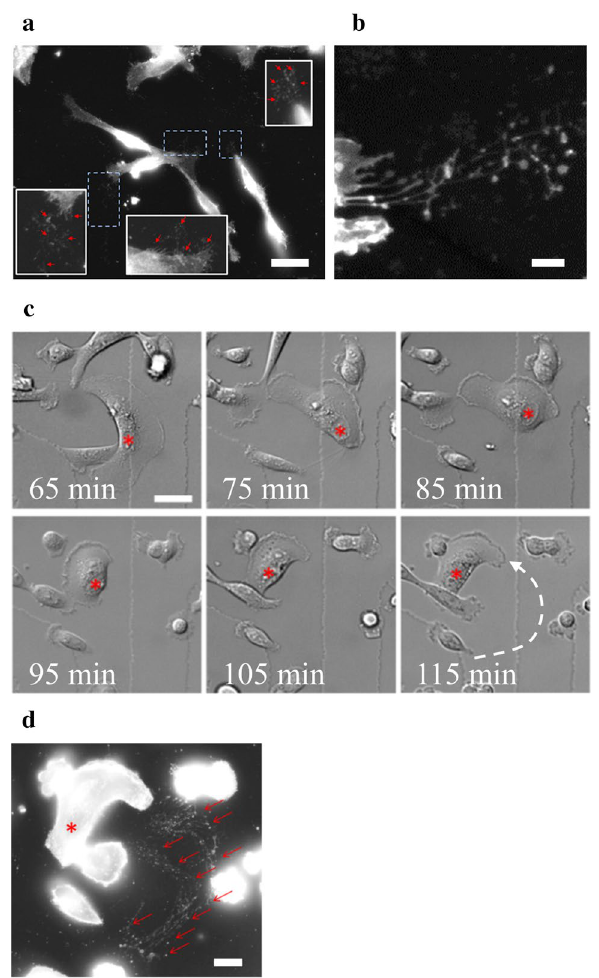
Figure 2. Presence of membrane fragments during MDA-MB-231 cell migration on collagen I fibrils. ( a ) MDA-MB-231 cells were seeded on a glass coverslip coated with collagen I. 24 h after seeding, kinetics study of cell migration was performed during 2 h by phase-contrast video-microscopy. Cells were then incubated with CellMask Orange (white). Red arrows indicate membrane material at the periphery of cells. Scale bar: 60 µm. ( b ) Observation at higher-magnification by fluorescence microscopy revealed the presence of membrane material stained by CellMask Orange (white), which appears as membrane-bound vesicular structures. Scale bar: 5 µm. ( c ) Kinetics study enabled to identify a migrating cell, for which the nucleus has been marked by a red asterisk. The dashed white arrow indicates the path of the cell during the migration. Scale bars: 40 µm. ( d ) After migration, cells were immediately incubated with CellMask Orange (white) for 5 min and fixed with 4% paraformaldehyde. Red asterisk marks the nucleus of the cell of interest presented in c and red arrows indicate membrane fragments present in the wake of the cell. Scale bar: 20